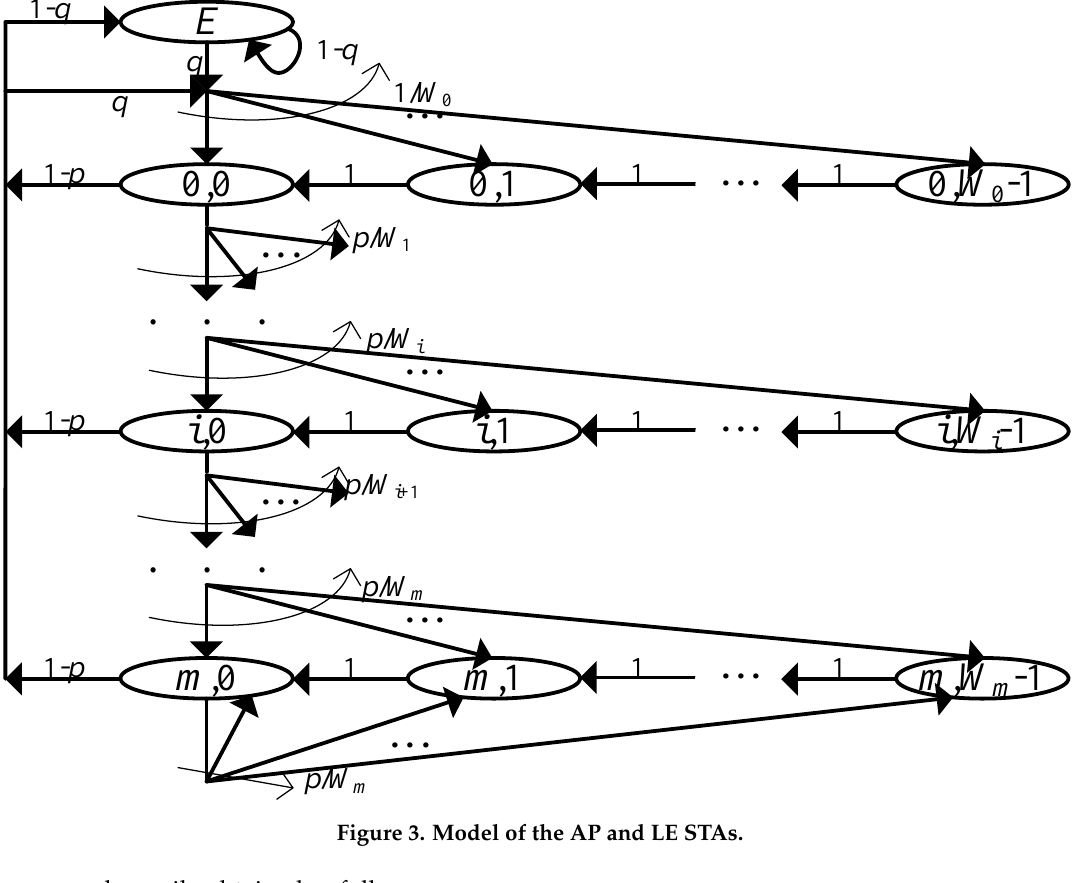
Figure 3. Model of the AP and LE